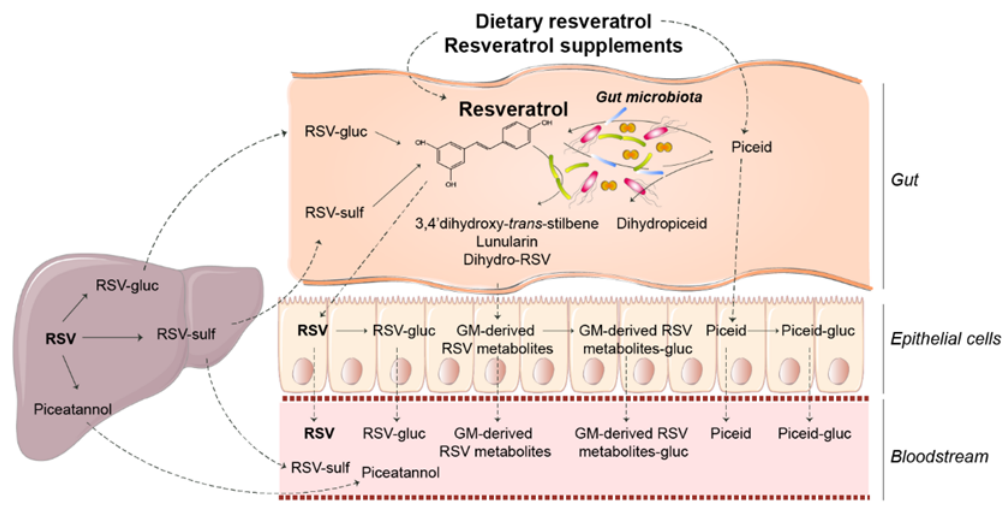
Figure 1. Overview of the metabolism of resveratrol and the impact of gut microbiota. Upon intake, RSV and RSV precursors enter the gut and are partly metabolised by gut microbiota to produce particular RSV derivatives and RSV. Free RSV, RSV precursors and microbiota-derived RSV metabolites are conjugated in the intestine and liver, from where conjugated forms can return to the intestine. In the liver, RSV is metabolised to piceatannol, which can be released into the bloodstream, and delivered to target tissues together with RSV, RSV precursors, microbiota-derived RSV metabolites and their respective conjugate forms. RSV, resveratrol; gluc, glucuronides; sulf,